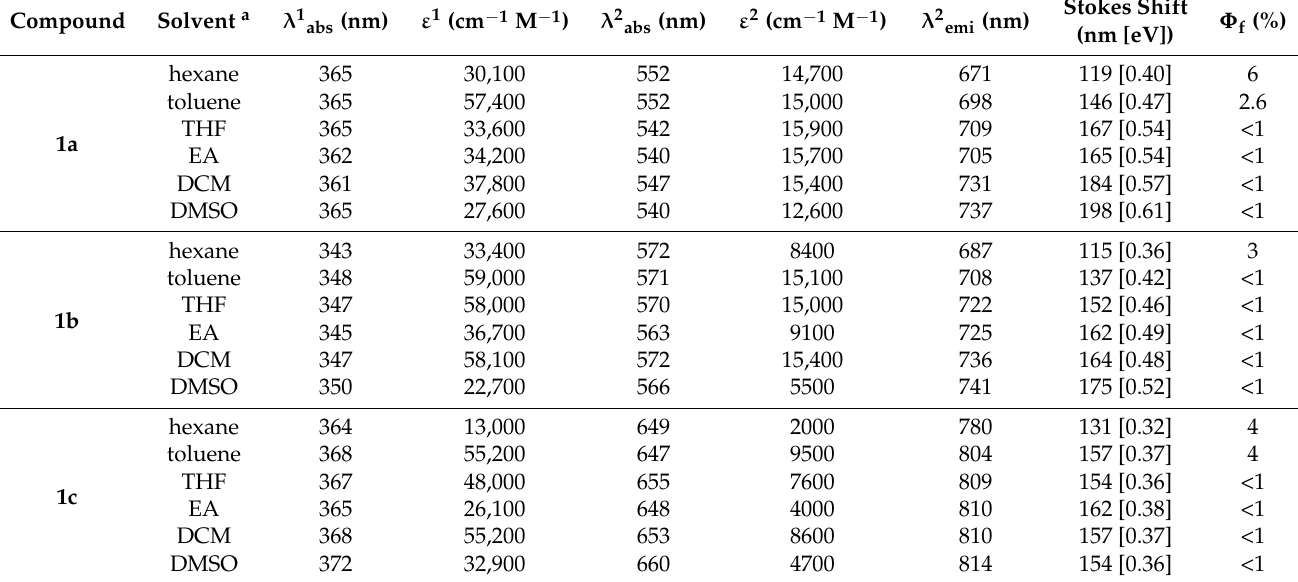
Table 1. Optical properties of luminophores 1a – c in different